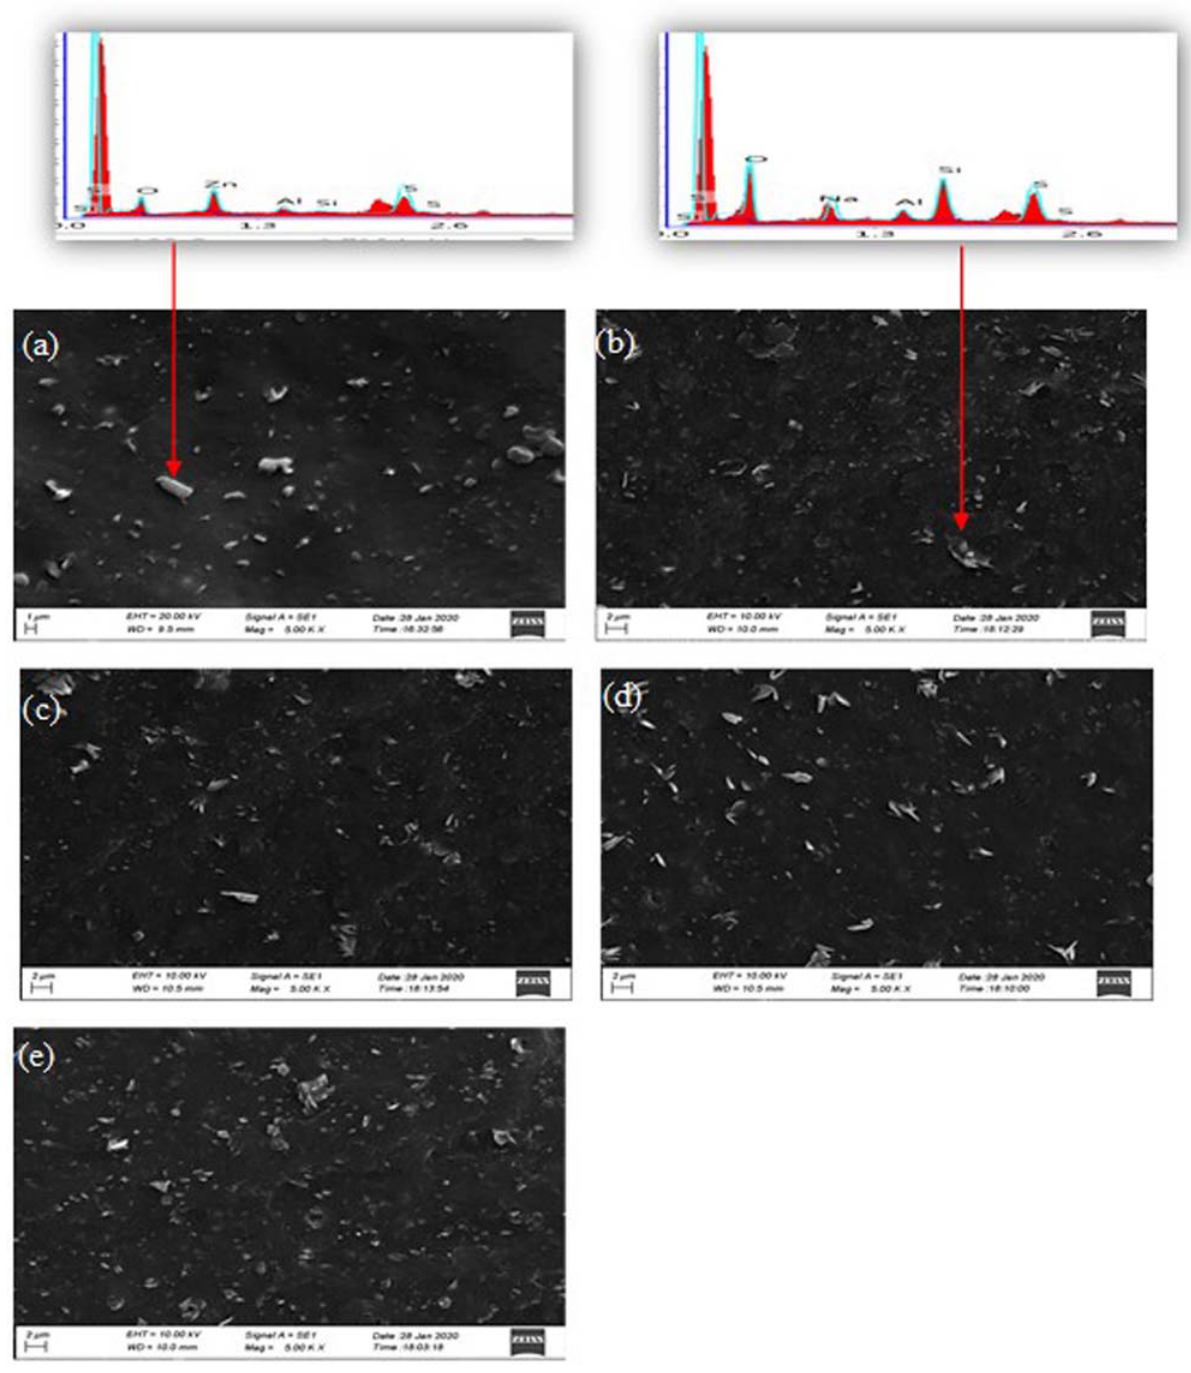
Figure 6: SEM images of nanocomposites ( a ) Control, ( b ) C - 2, ( c ) C - 5, ( d ) S - 2 and ( e ) S -